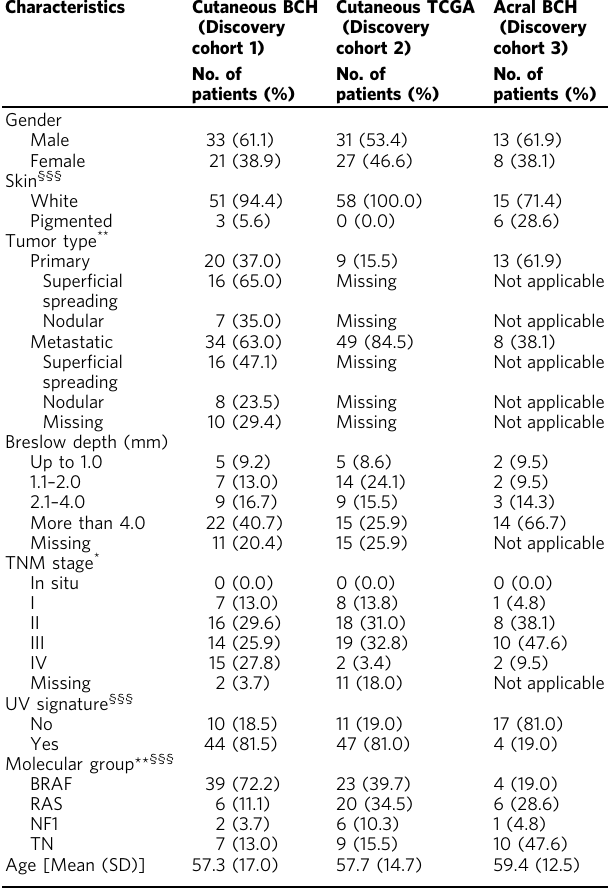
Table 1 Clinicopathological characteristics of the BCH- cutaneous melanoma patients, TCGA-cutaneous melanoma patients, and BCH-acral melanoma patients pro fi led with the DNA methylation